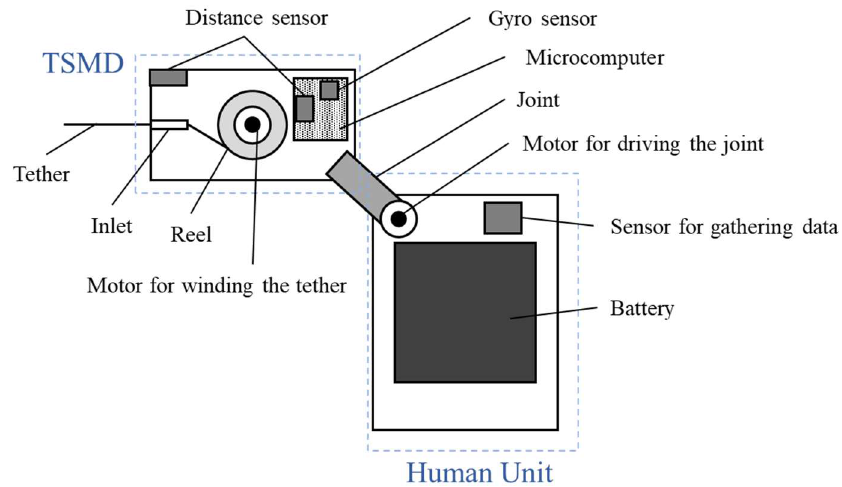
Figure 5. Schematic of experimental device.